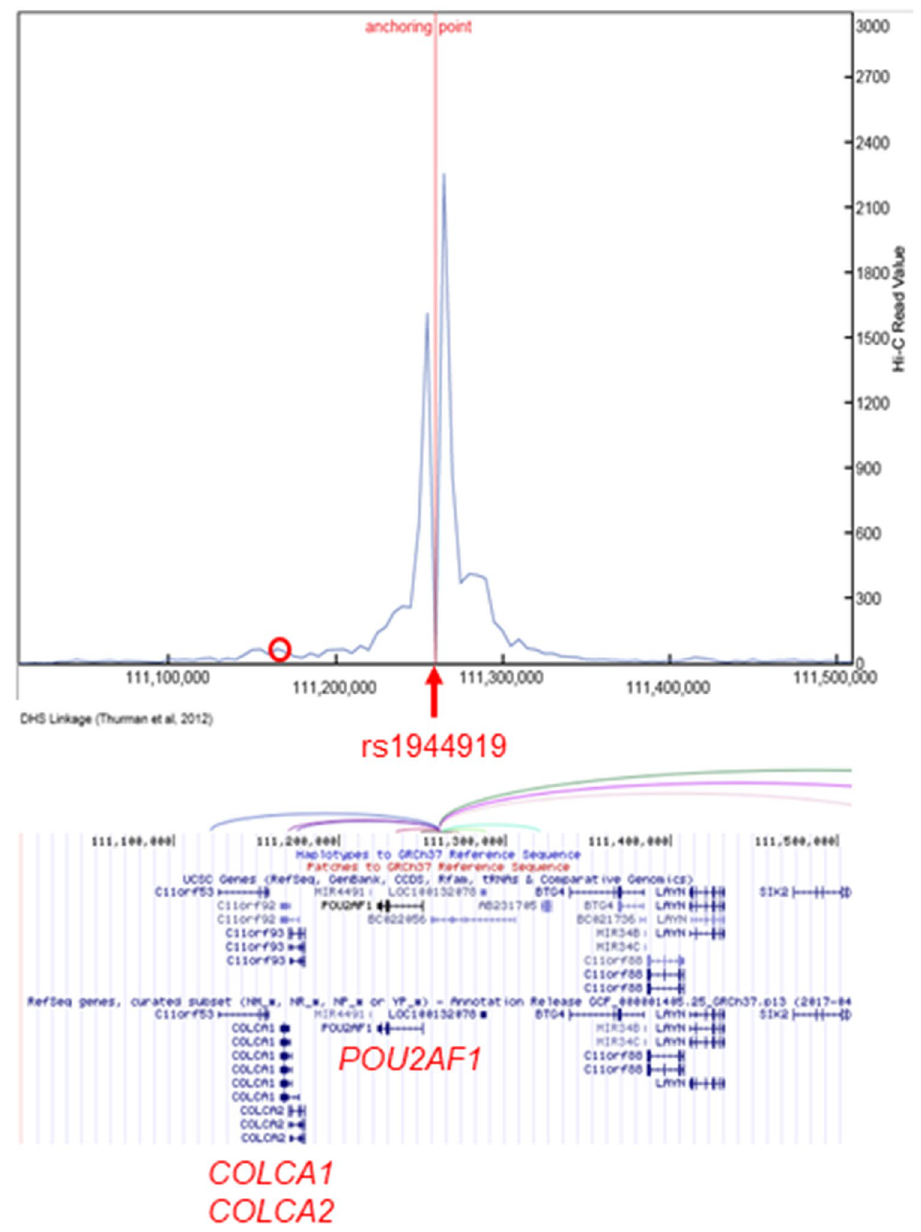
Figure 4. Chromatin interactions between the 5-kb window containing rs1944919 and upstream sequences of COLCA genes. Vertical line indicates the strength of interaction, which is denoted by a red circle. Interaction of the DNase high-sensitivity site (DHS; Thurman et al. 2012) also indicated an interaction between the two